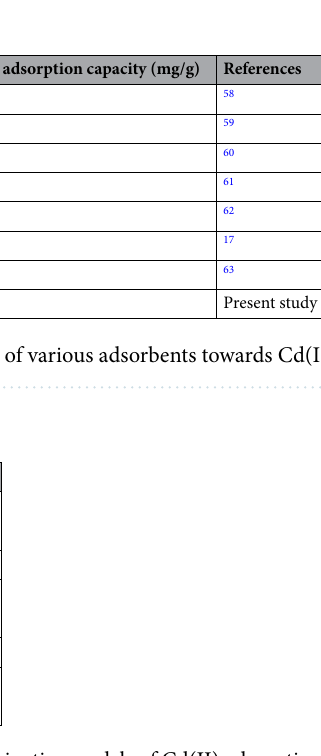
Table 8. R 2 and constant values for different adsorption kinetics models of Cd(II) adsorption onto HAp/ bentonite